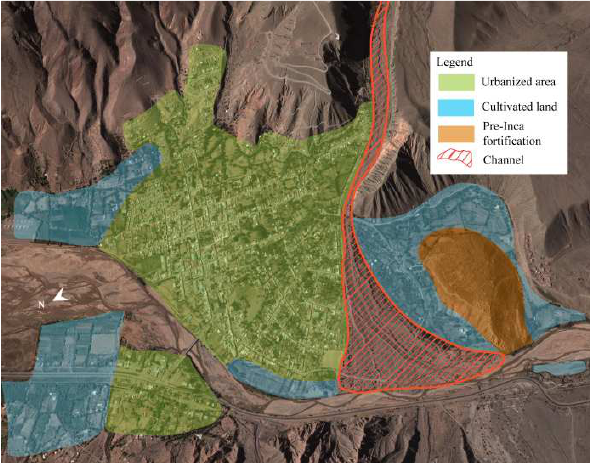
Fig. 5. Land use in the Tilcara alluvial fan. Image source: Google Earth